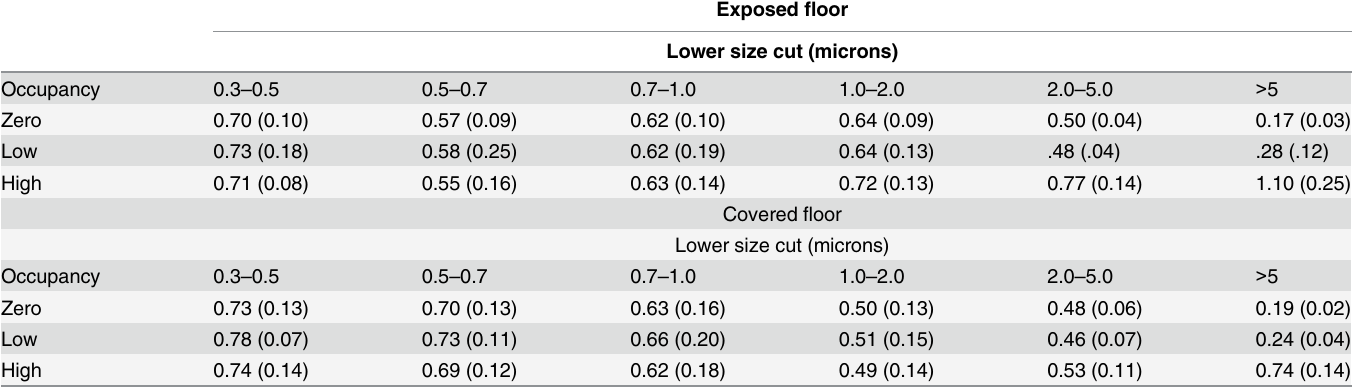
Table 3. Particle number concentrations.